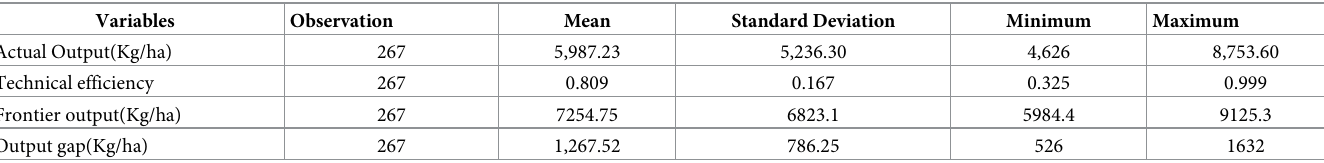
Table 6. Tomato yield gap and mean technical